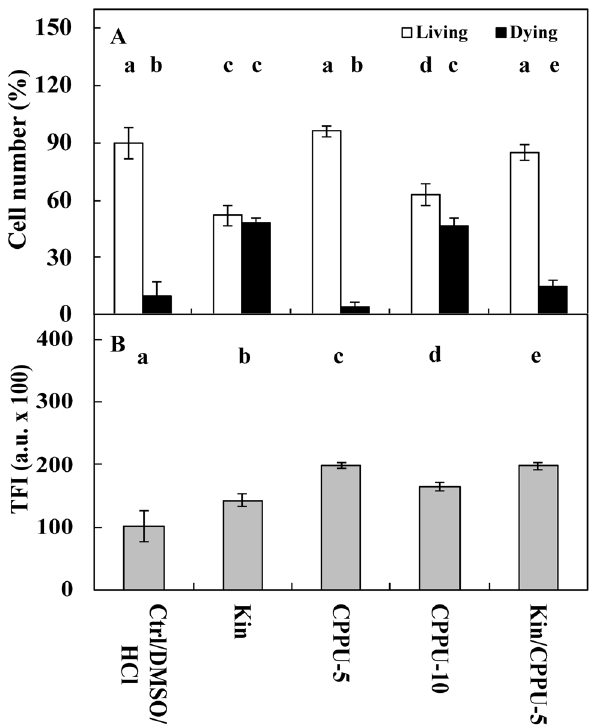
Figure 3. Number (%) of living and dying cells ( A ) as well as cytosolic calcium ion (Ca 2+ ) amounts ( B ) in Vicia faba ssp. minor cortex seedling apical roots after treatment with CPPU, an inhibitor of cytokinin oxidases. The number of living and dying cells as well as the amounts of Ca 2+ were fluorescently estimated after staining with acridine orange, ethidium bromide and chlortetracycline. Bars indicate ± SE of the results from three biological replicates. The means of the results with the same letter above the column are not significantly different at p ≤ 0.05. CPPU–5, 5 μM CPPU; CPPU–10, 10 μM CPPU; Ctrl, control; DMSO, dimethyl sulfoxide; Kin, kinetin; Kin/CPPU–5, kinetin with 5 μM CPPU.